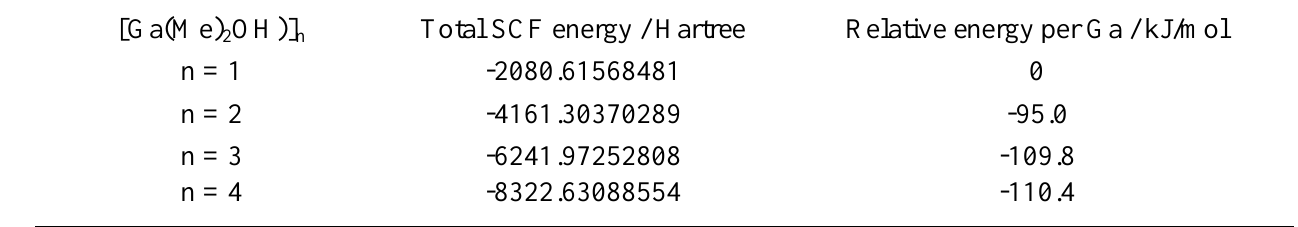
Table 2 . Selected bond lengths and bond angles for [Me